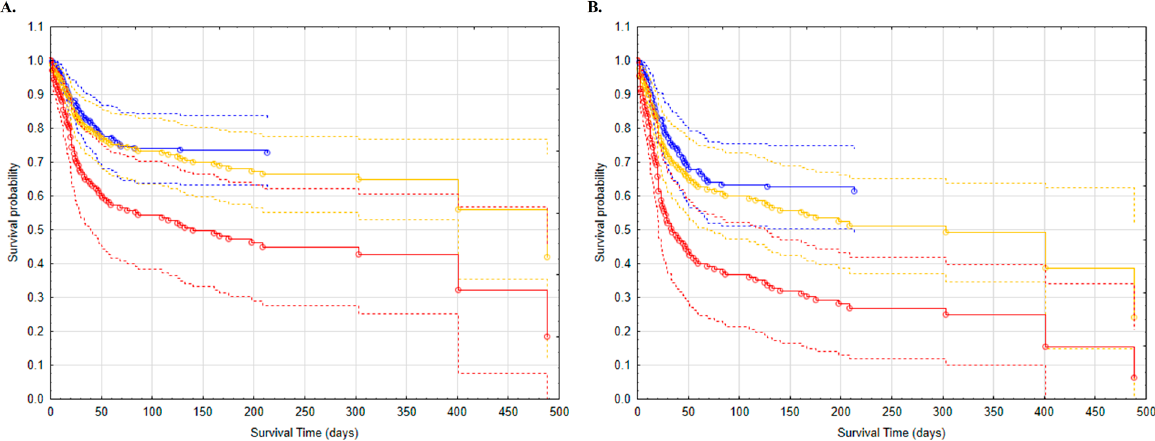
Figure 1. Survival analysis of patients with COVID-19: without cancer (blue); with cancer but without metastases (yellow); with cancer with metastases (red). ( A ) women; ( B ) men.